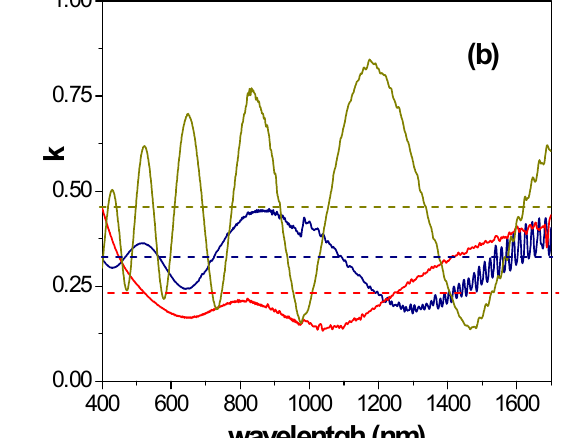
Figure 6. Effect of an Ox(A) support coated layer on refractive index (n) and extinction coefficient (k) for wavelengths ranging between 250 nm and 1700 nm determined at three different light incident angles. ( a , b ): Ox(A)/TiO 2 sample; ( c , d ): Ox(A)/Fe 2 O 3 sample.